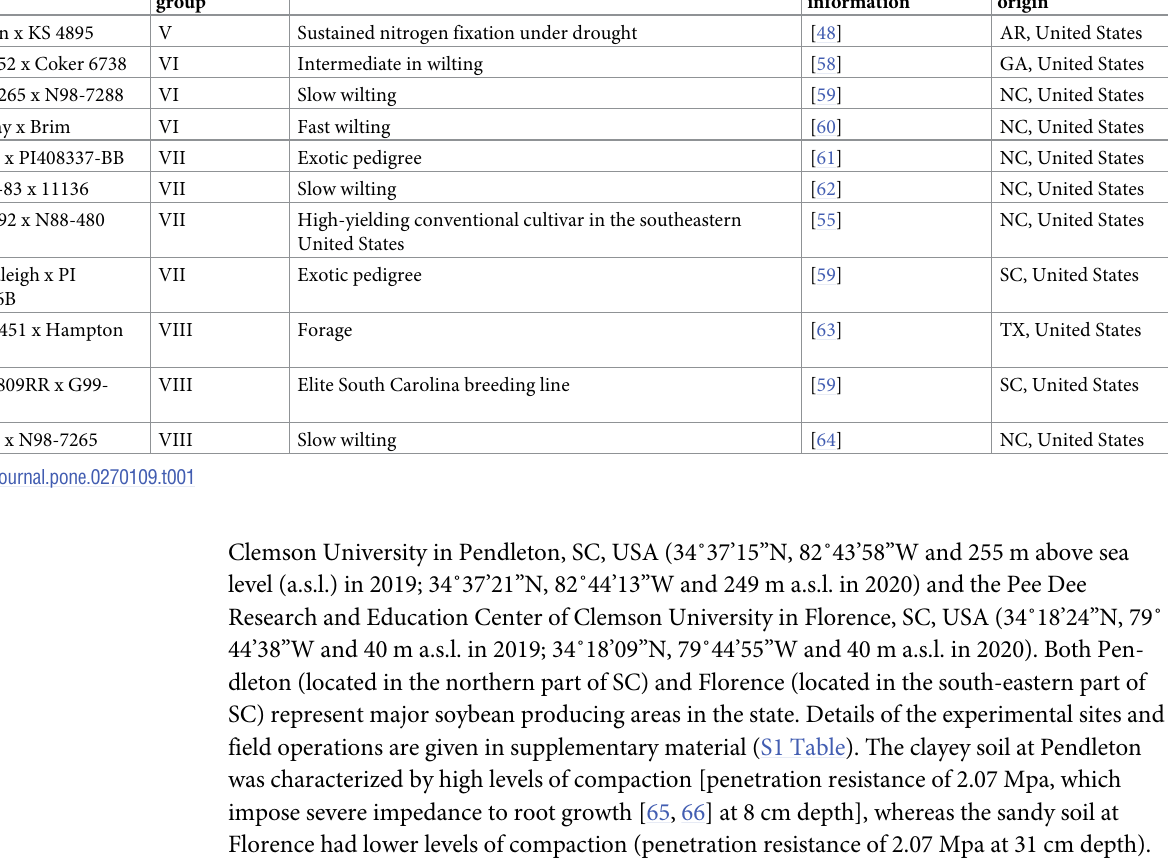
Table 1. Characteristics of the soybean genotypes used in the study. Genotype